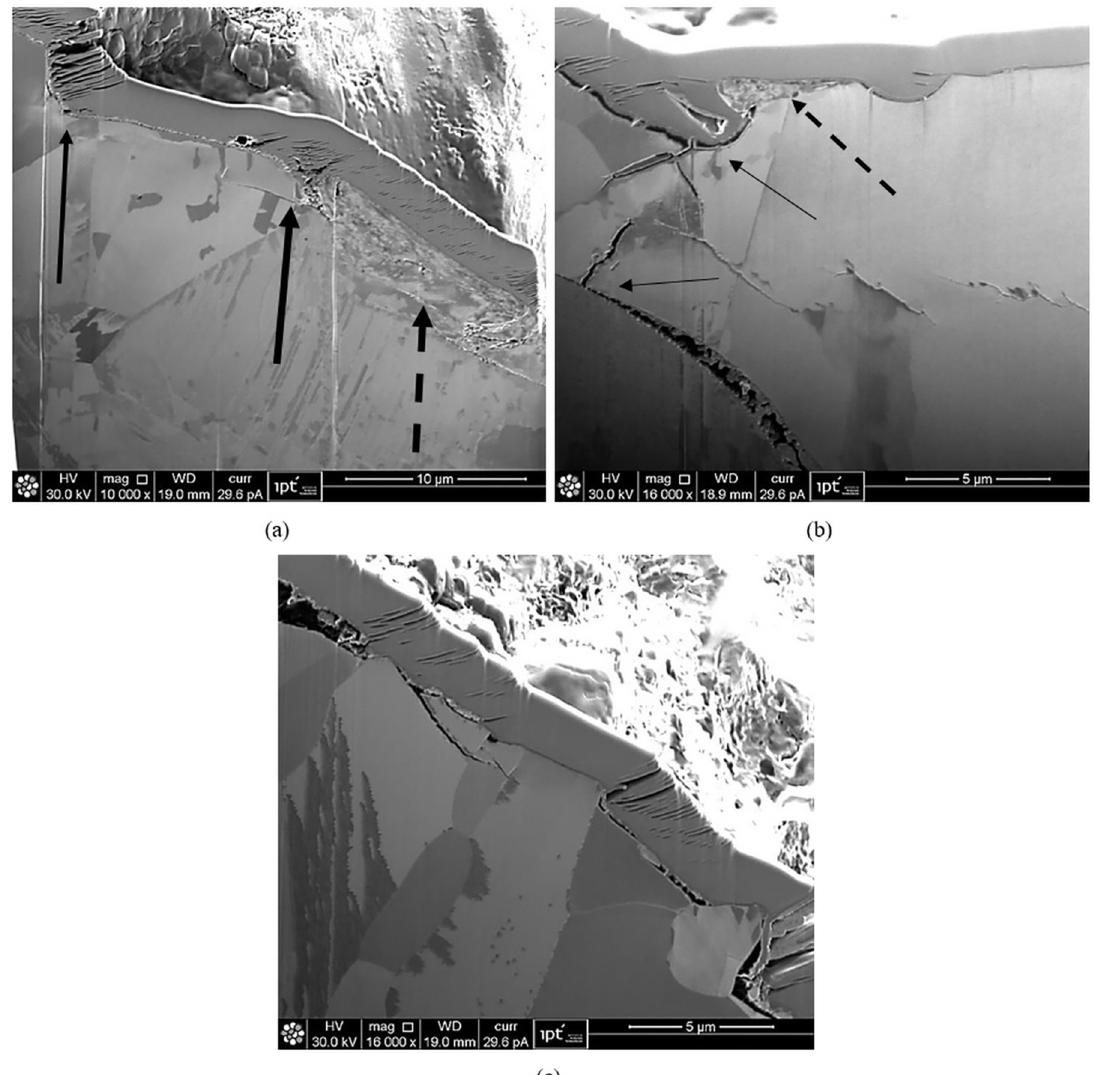
Figure 12. Microestrutural characterization below the exposed SCC surface after DET at 110 °C. (a) UNS S31603 ASS tested at 100 % of the yield stress (278 MPa); (b) UNS S32205 DSS tested at 100 % of the yield stress (473 MPa); (c) UNS S32750 SDSS tested at 100 % of the yield stress (589 MPa).